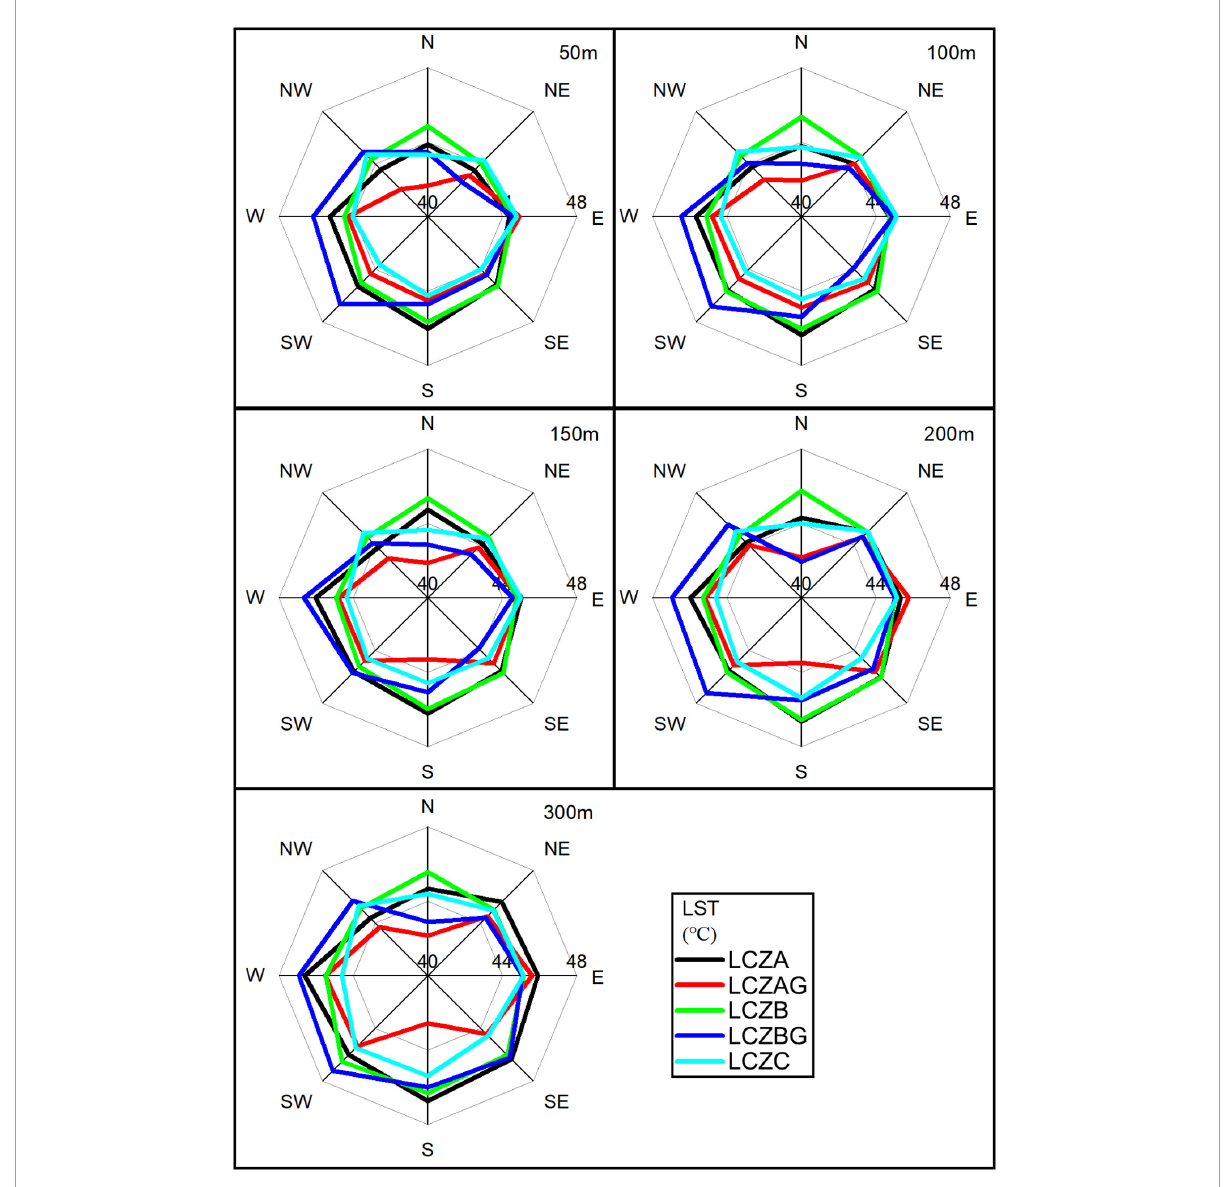
FIGURE8 The distribution of LST around parks. Eight axes present the LST located around parks in eight